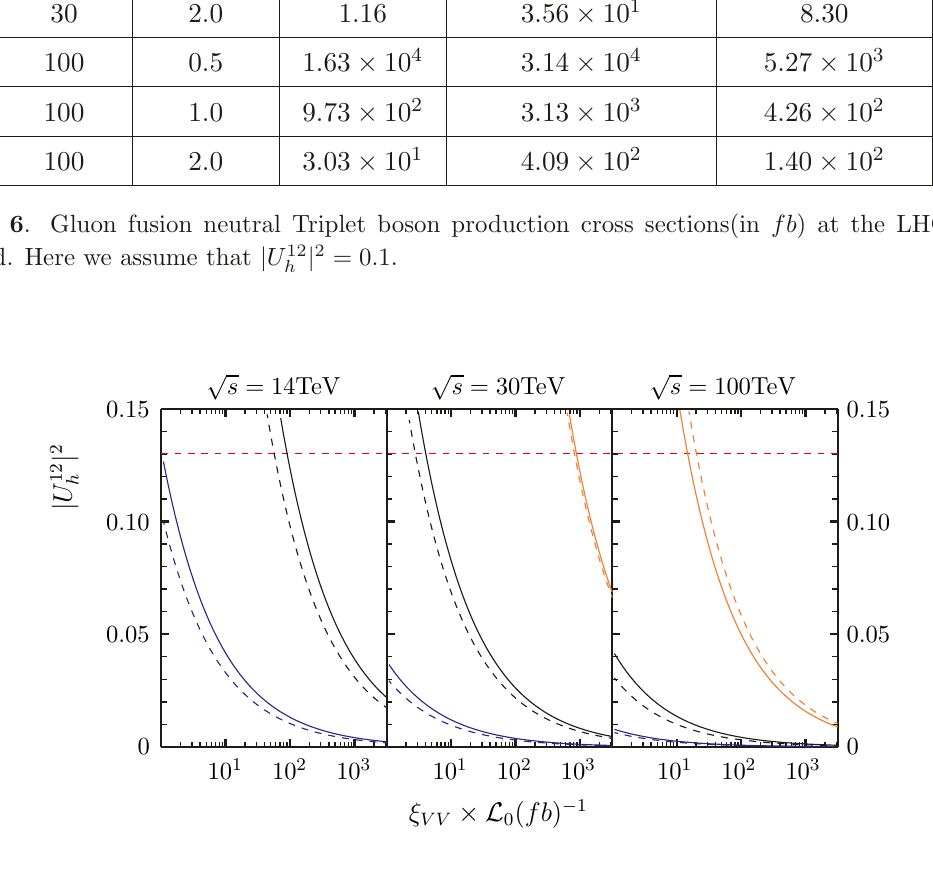
ZZ . The color codes, (blue, black, orange), are for M T = →